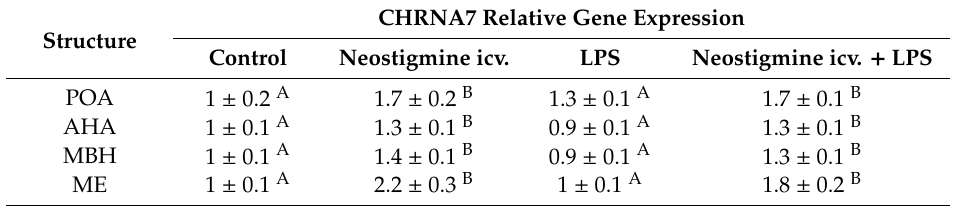
Table 2. E ff ect of lipopolysaccharide (LPS; 400 ng / kg; intravenous) and neostigmine (1 mg /